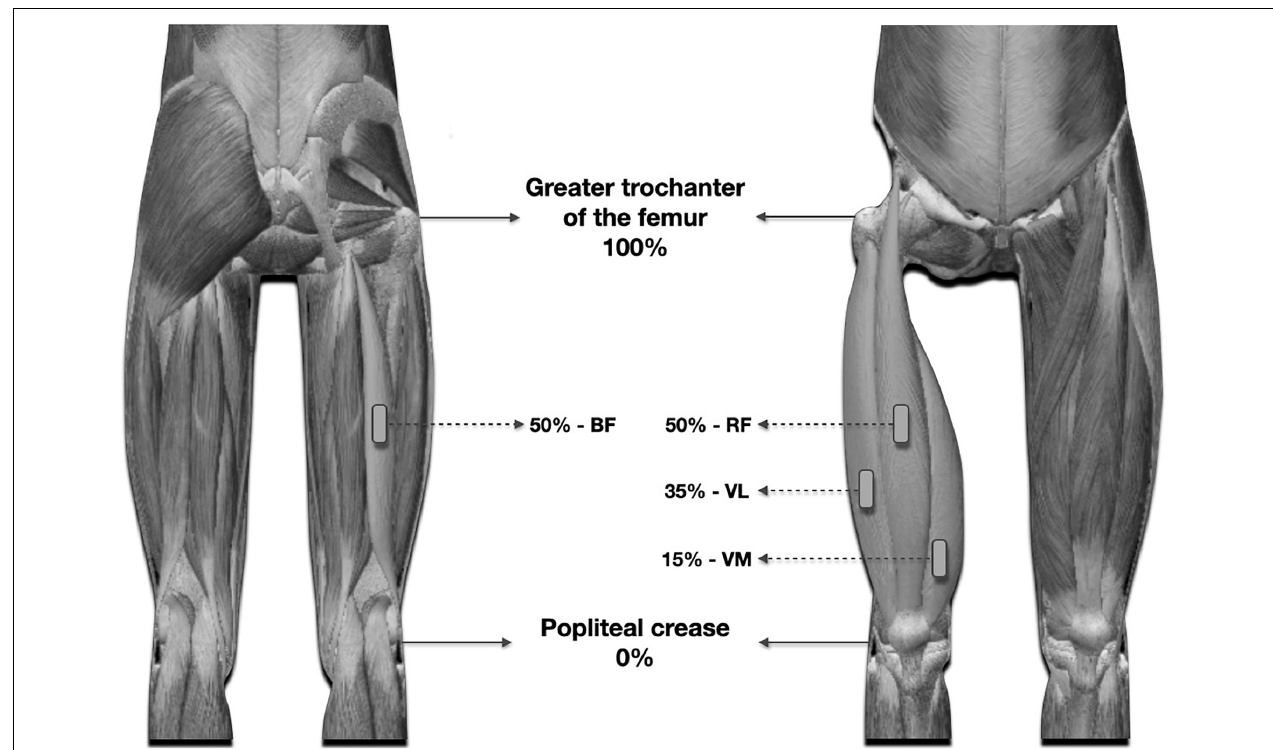
FIGURE 2 | Illustration of the anatomical points used for ultrasound measurements and fixation of surface electrodes, for the evaluation of EMG.